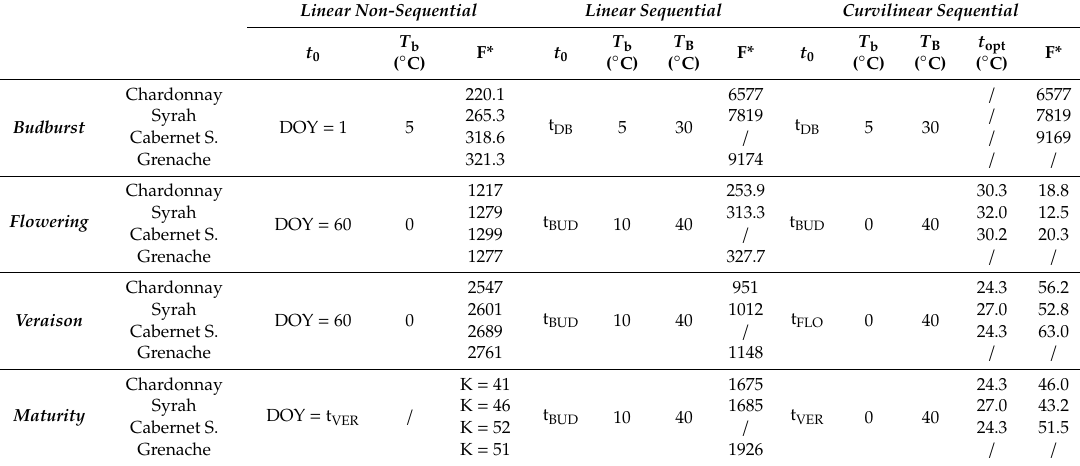
Table 1. Values of parameters and calibration of the di ff erent phenological models for the di ff erent varieties. Linear Non-Sequential Linear Sequential Curvilinear